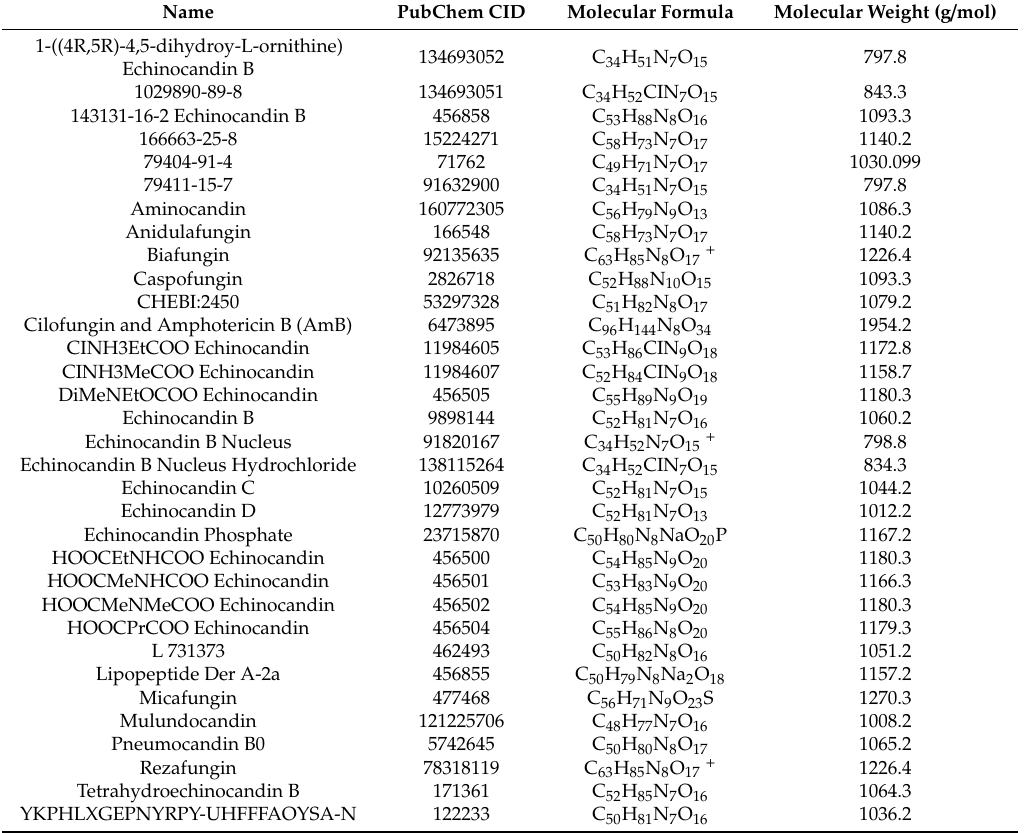
Table 1. Echinocandin entries in PubChem